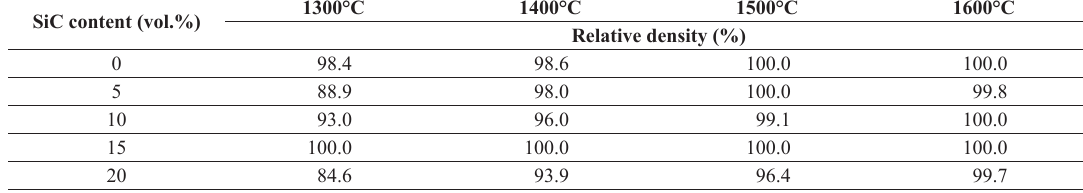
Table 1: Effect of SiC Reinforcement on the Relative Density of Sintered Composites SiC content